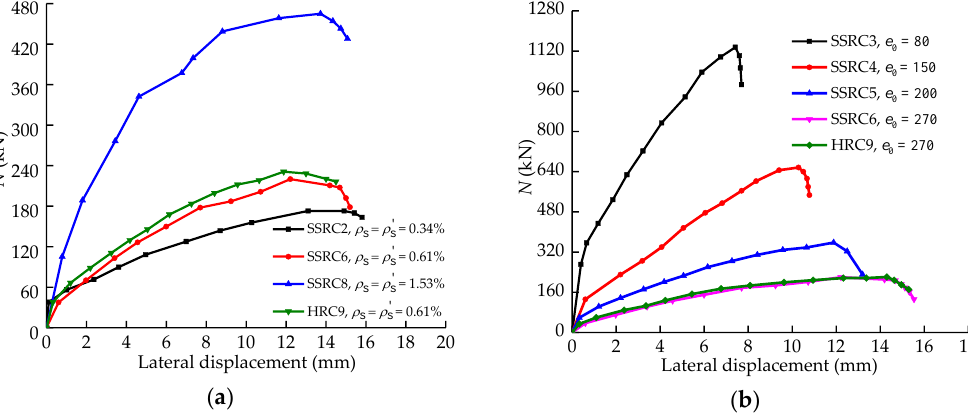
Figure 5. Load – lateral displacement curves for various ( a ) reinforcement ratios and ( b ) eccentricities.